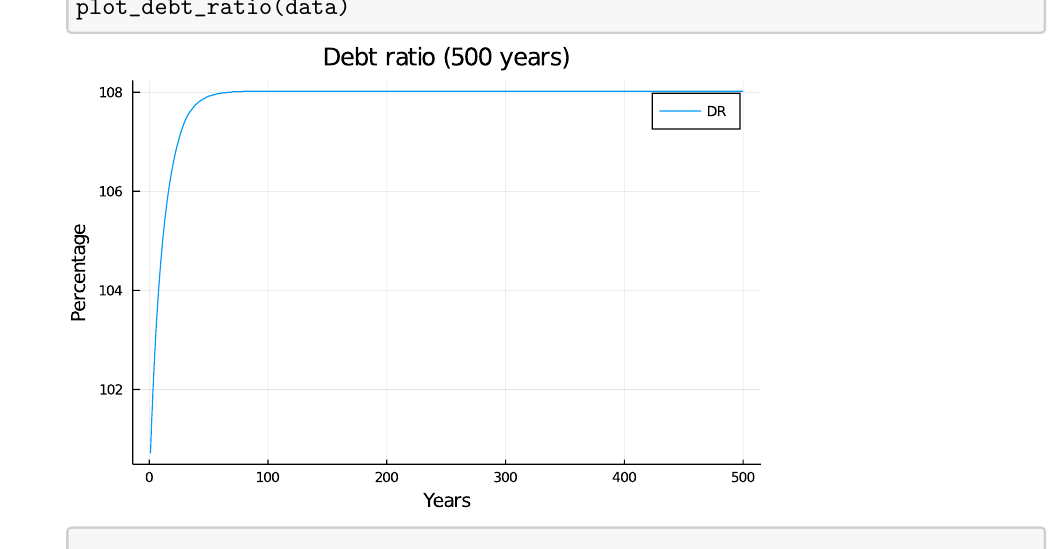
Figure 19. Debt ratio (LR = 14.9%, p = 0.8%, m = 30 years).